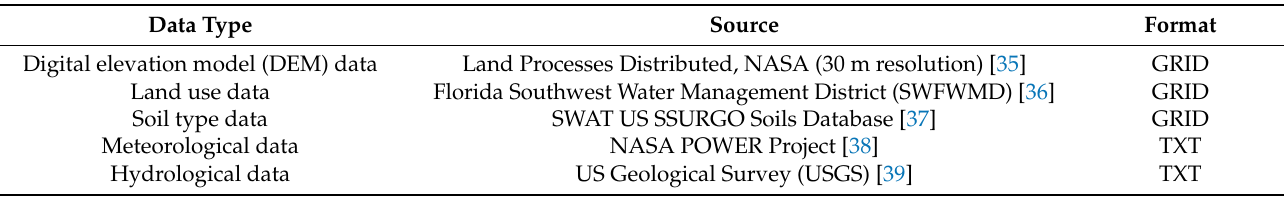
Table 1. Data required for model operation and their